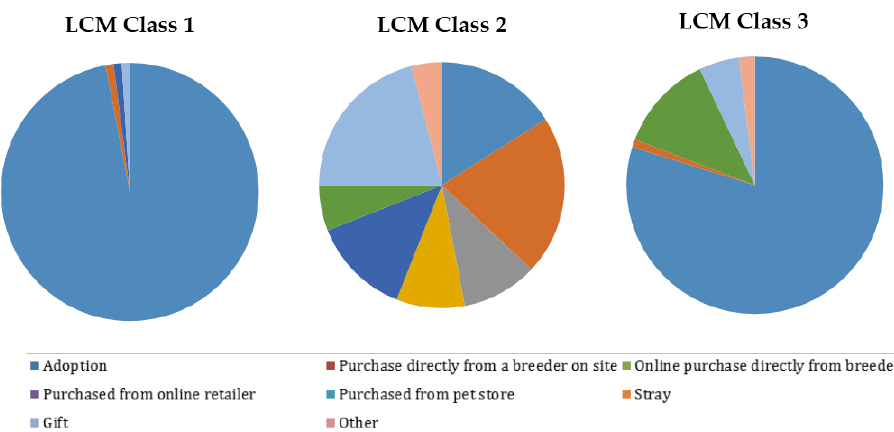
Figure 2. Preference shares for LCM classes .